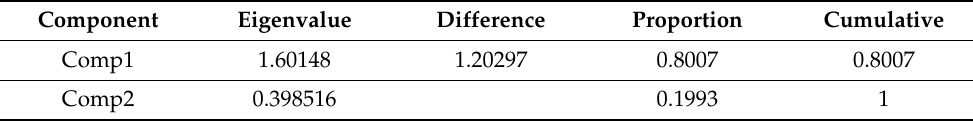
Table 3. Principal component analysis.